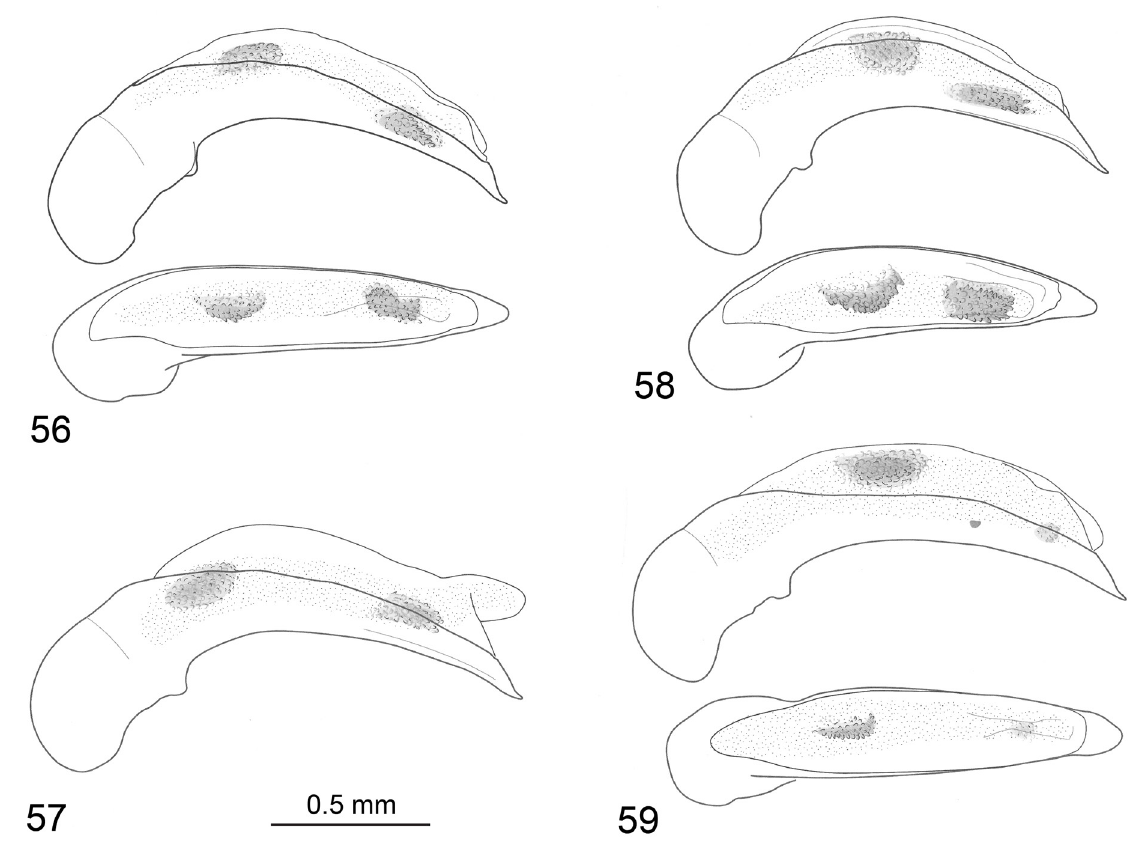
Figs 56–59. Group of Dyscolus verecundus Moret, 1998, male aedeagus, median lobe in lateral and dorsal view. 56 . D. verecundus , paratype from Rucu Pichincha. 57 . D. verecundus , paratype from Guagua Pichincha. 58 . D. verecundior Moret sp. nov., holotype (MNHN, COI voucher PM136- 04);. 59 . D. verecundissimus Moret sp. nov., holotype